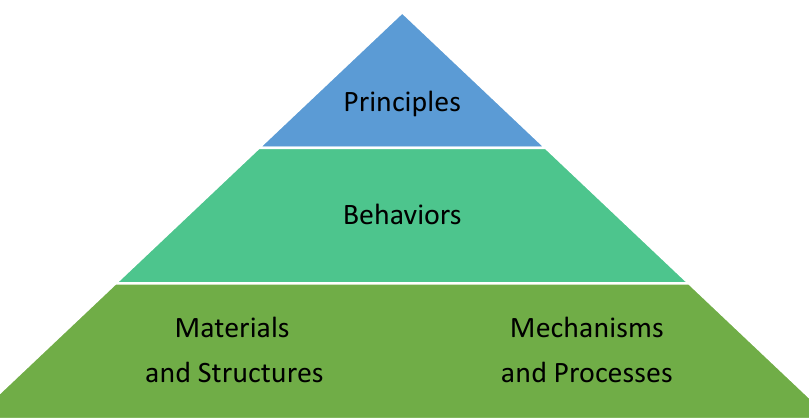
Figure 1. Hierarchy of abstraction levels, adapted from Mak and Shu [11].